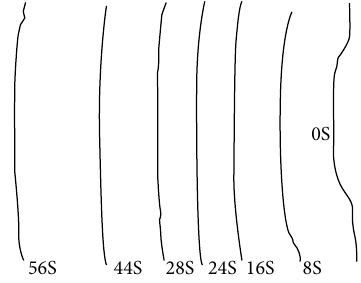
Figure 8: Imaging of grain end at each di ff erent moments of